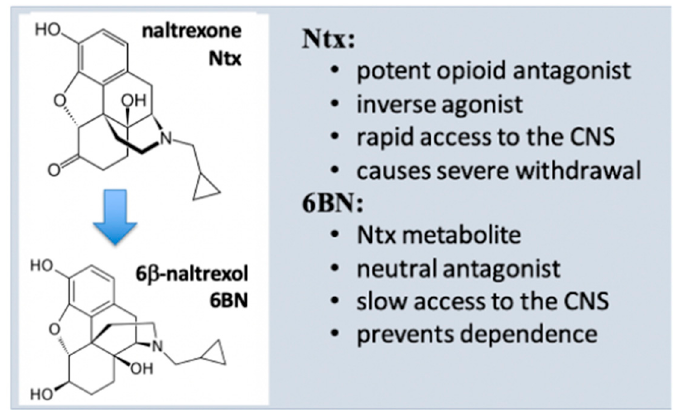
Figure 2. Pharmacological properties of naltrexone and 6 β -naltrexol. Pharmacokinetic parameters of 6BN differ from those of naltrexone. The elimination half-life of 6BN from blood in humans (~12h) is longer than that of naltrexone (~4h) [62], (and references therein). As a result, 6BN blood levels exceed naltrexone levels